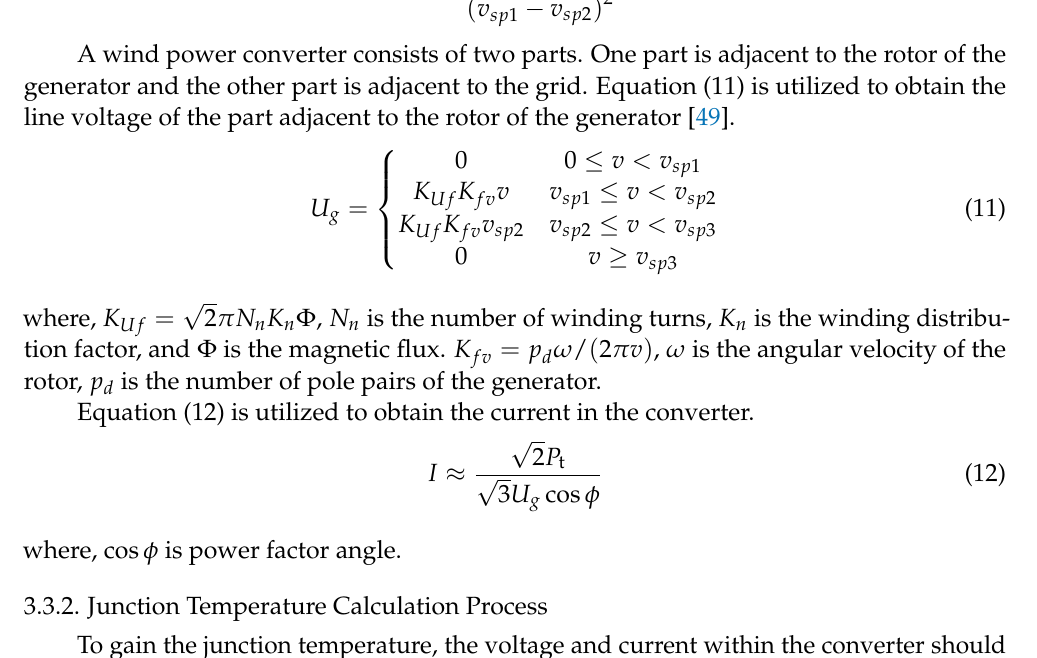
Figure 5. Junction temperature wave for one year in a 2 MW wind turbine. 3.4. Modeling of Junction Temperature Prediction Based on IHBA-ELM The electro-heat coupling model method is accurate. However, it is too complex, and there are many sensors that need to be set up in order to obtain the operation data of wind turbines. It is not suitable for performing long-term tasks. Therefore, in this section, a sim- ple junction temperature prediction model was proposed. According to Section 3, the junction temperature of IGBTs was mainly related to wind speed and cabin temperature. Therefore, the junction temperature prediction model proposed in this study took them as input quantities. 3.4.1. Principle of Extreme Learning Machine and Honey Badger Algorithm The network structure of the ELM consists of an input layer with n variables, a hid- den layer with l variables, and an output layer with m variables. Suppose